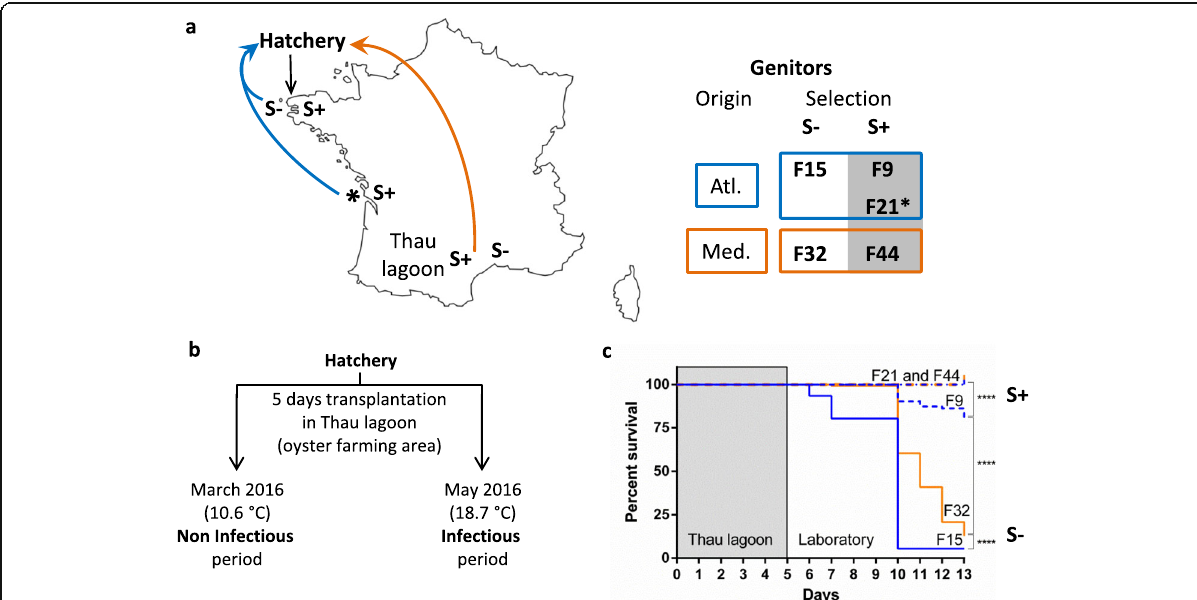
Fig. 1 Production of oyster families with different level of resistance to Pacific oyster mortality syndrome (POMS). a Origin of genitors and production of the five biparental families. Four pairs of wild genitors were collected either in aquaculture (S+) or non-aquaculture (S-) areas on Atlantic (Atl.) or Mediterranean (Med.) coasts (blue and orange lines, respectively). The fifth pair of genitors (*) comes from a mass selection program (more details in method section). Genitors coming from aquaculture areas were assumed to be exposed to stronger selection pressure due to mass mortality outbreaks occurring annually at these sites. b Transplantation experiments. Oysters from the five families were raised in the hatchery under the same controlled conditions, and subsequently transplanted into the Thau lagoon either before (non-infectious period) or during a mortality outbreak (infectious period). c Survival curves for the five oyster families after transplantation into the Thau lagoon during the infectious period (a minimum of 125 oysters was used for survival tests). Day 5 corresponds to the end of the transplantation, when oysters were brought back to the laboratory. Resistant and susceptible oyster families are indicated by S+ and S-, respectively. **** p < 0.0001